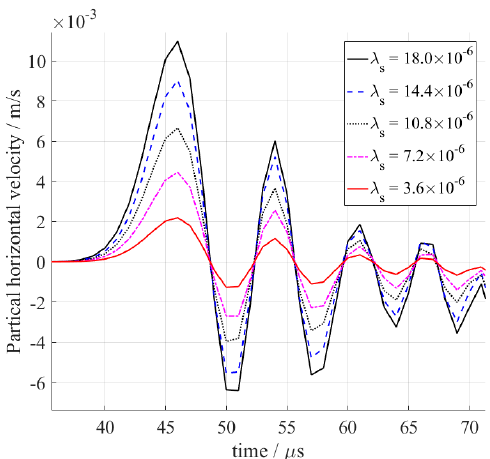
Figure 5. Received S0 Lamb waves with different magnetostriction coefficients.